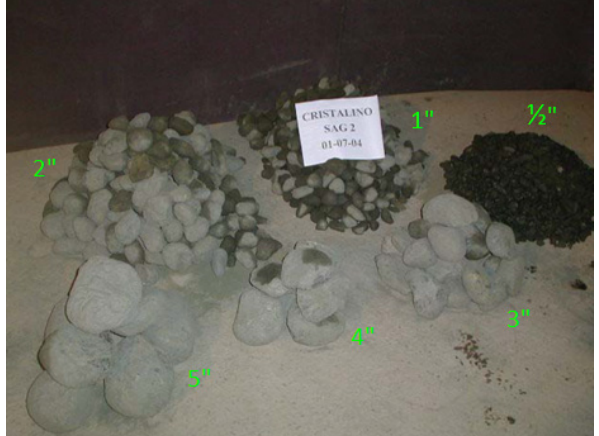
Figure 4. SAG mill internal ore charge after SAG-2